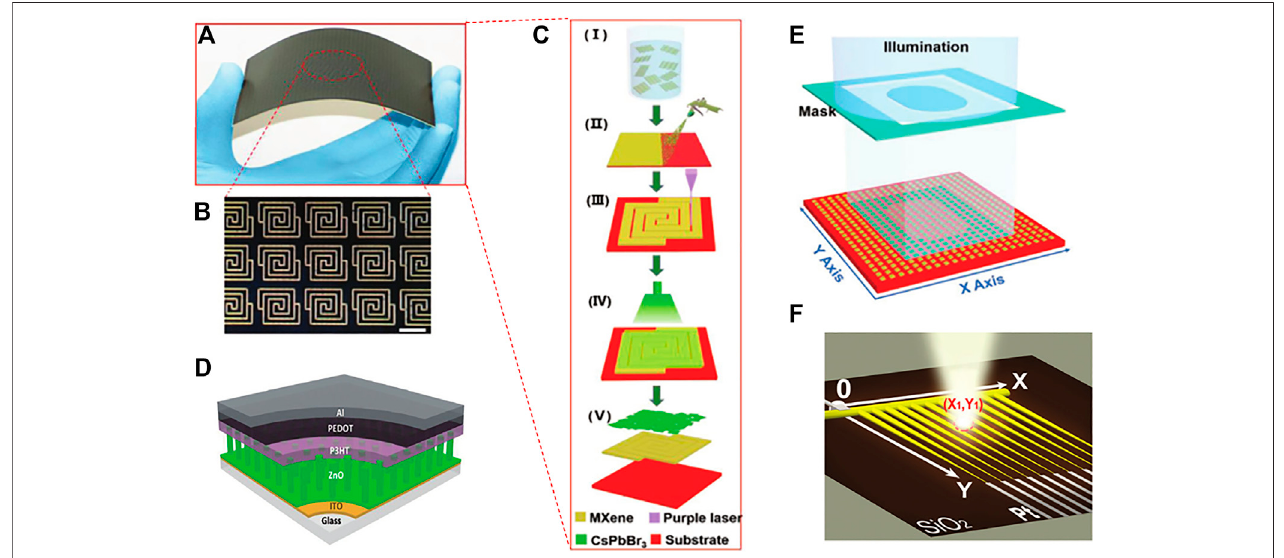
FIGURE 1 | (A) Exhibition of large-area arrays MXene electrode. (B) Micro pattern corresponding to (A) . (C) Schematic diagram of fl exible photodetector processing process. (D) Schematic of the P3HT/ZnO heterojunction photodetector. (E) Schematic diagram of a digital sensor based on a large-area array photodetector. (F) Schematic diagram of the CdS branched